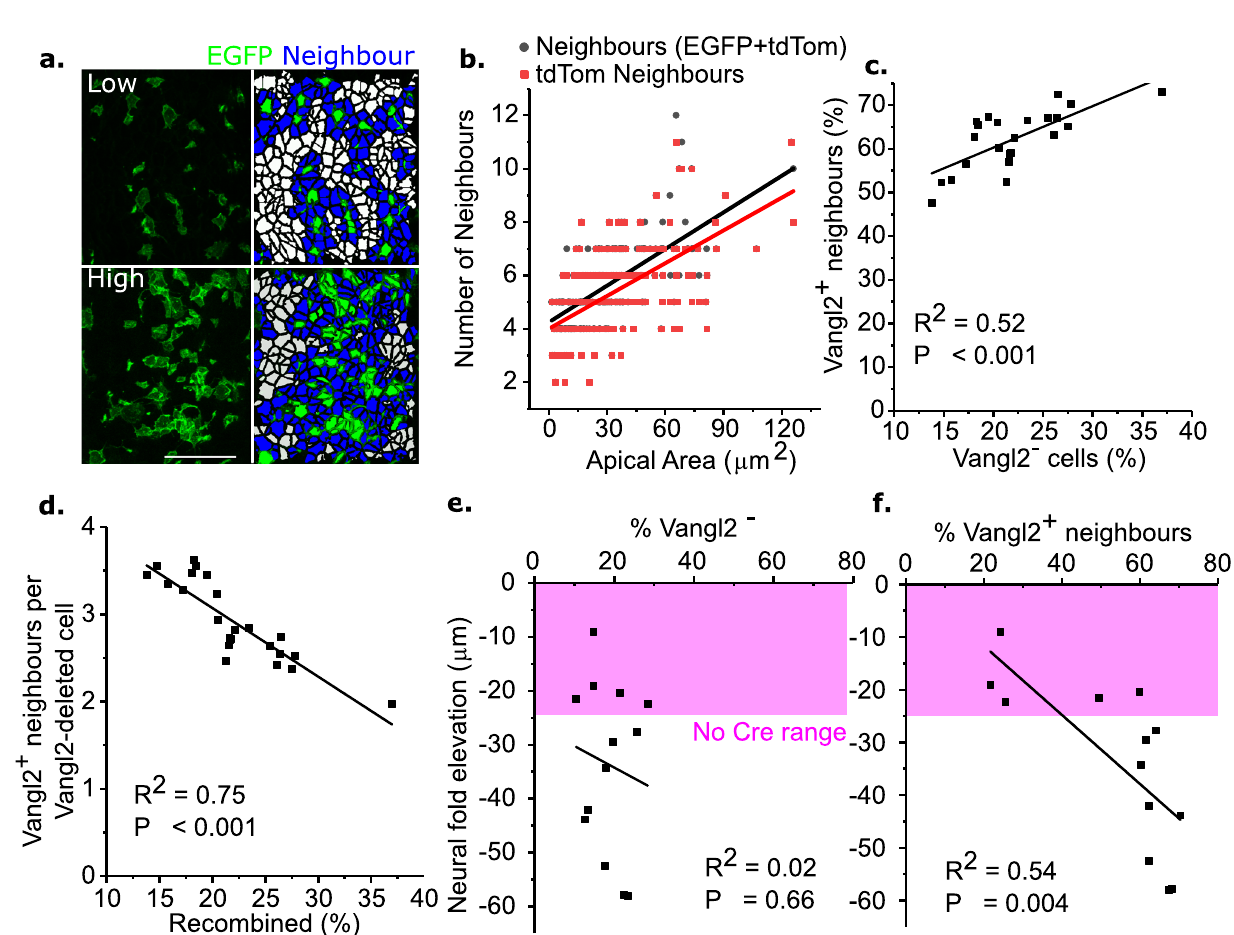
Fig. 7 The proportion of Vangl2 -replete cells neighbouring a deleted cell correlates with PNP eversion. a Illustrative examples of surface-subtracted neuroepithelia with low and high levels of EGFP recombination. Cell borders were determined from ZO1 staining. Green = Vangl2 -deleted, blue = neighbour and white = distant cells. Scale bar = 50 µ m. b Correlation between apical area and the number of neighbours (as predicted by Lewis ’ law) of Vangl2 -deleted cells. EGFP + cells infrequently neighboured each other so total and Vangl2 -replete (tdTom) cells were counted separately. Each dot represents a cell (234 cells from three embryos). c Positive correlation between the proportion of neuroepithelial cells which are EGFP + and the proportion of EGFP − cells which neighbour an EGFP + cell. Each dot represents an embryo. d Inverse correlation between the proportion of unique Vangl2 -replete neighbours per Vangl2 -deleted cell and overall % Cre-mediated recombination, demonstrating that non-autonomous effect ampli fi cation is limited by neighbour-sharing. e , f Correlation between neural fold eversion (negative elevation) in Cre;Fl − embryos and the proportion of cells which are Vangl2 - deleted ( e ) or neighbours ( f ) in 15 – 20 somite stage embryos. The magenta box indicates the minimum degree of neural fold elevation observed in No Cre littermates. Each data point represents an individual embryo. p values and linear trend lines from Pearson